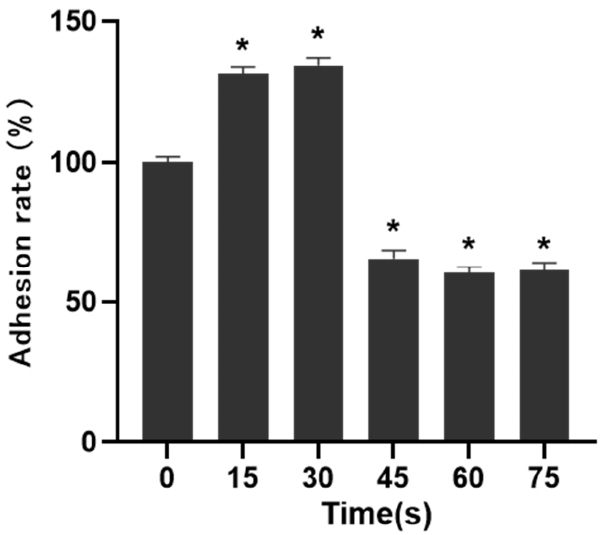
Figure 5. Effects of PAM on cell adhesion. The adhesion of cells in 15 s and 30 s-PAM groups was increased and the adhesion of cells in 45 s, 60 s and 75 s-PAM groups was significantly decreased. * compared with control group p < 0.05.